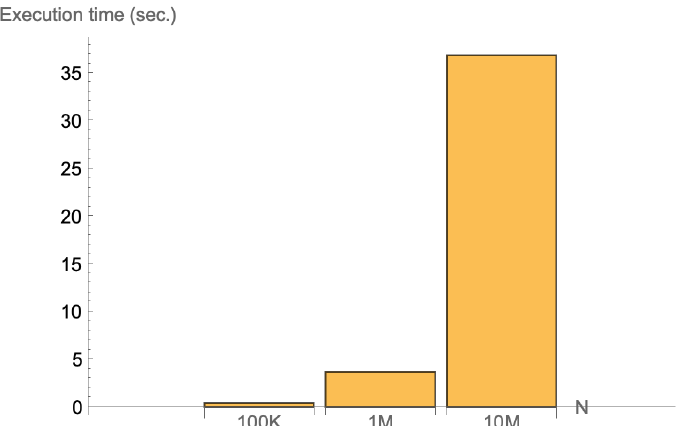
Figure 7. The execution time (in seconds) of P-Test using 100,000, 1,000,000, and 10,000,000